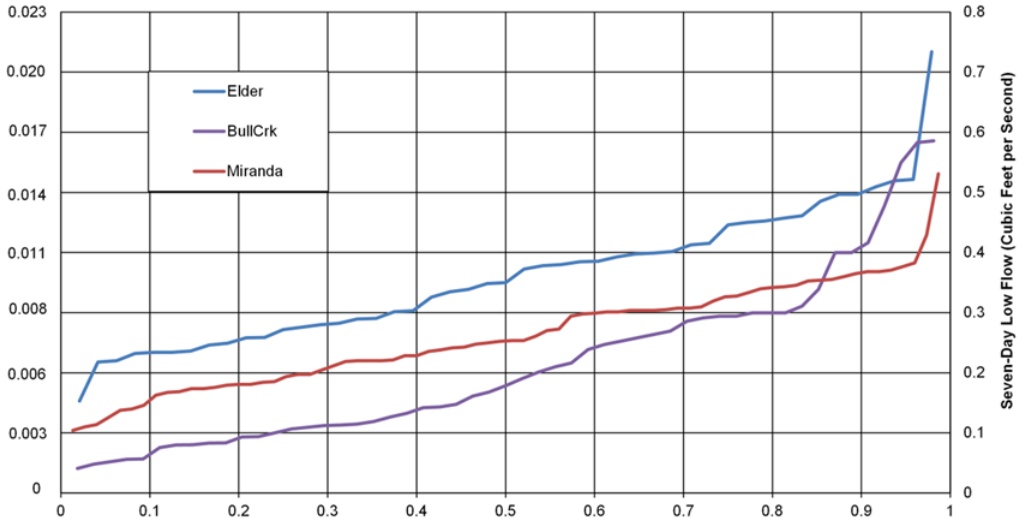
Fig 6. Duration curve of estimates of annual seven-day low flow for Redwood Creek South based on USGS data from nearby streams (Elder Creek, South Fork Eel at Miranda, and Bull Creek).